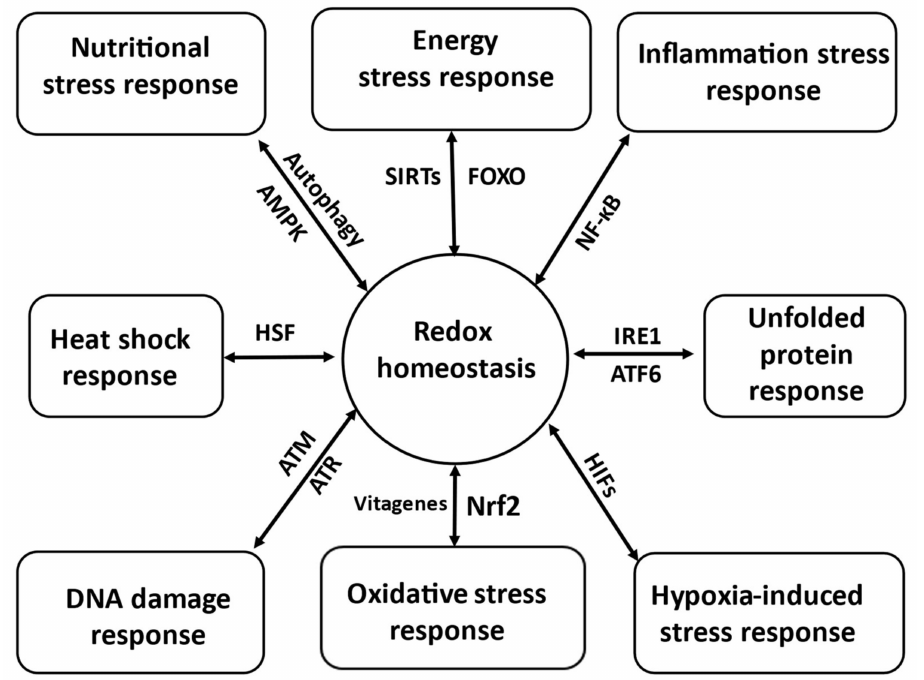
Figure 1. Hypothetical redox homeostasis and stress-response interaction scheme (adapted from [1,10,11,18,19]. AMPK, AMP-activated protein kinase; ATF6, activating transcription factor 6; ATM, ataxia-telangiectasia-mutated; ATR, ataxia-telangiectasia and Rad 3-related; FOXO, forkhead box protein; HIF, hypoxia inducible factor; HSF, heat shock factor; IRE1, inositol-requiring enzyme 1; NF- κβ , nuclear factor kappa-light-chain-enhancer of activated B cells; Nrf2, nuclear factor erythroid-2 related factor 2; SIRTs,